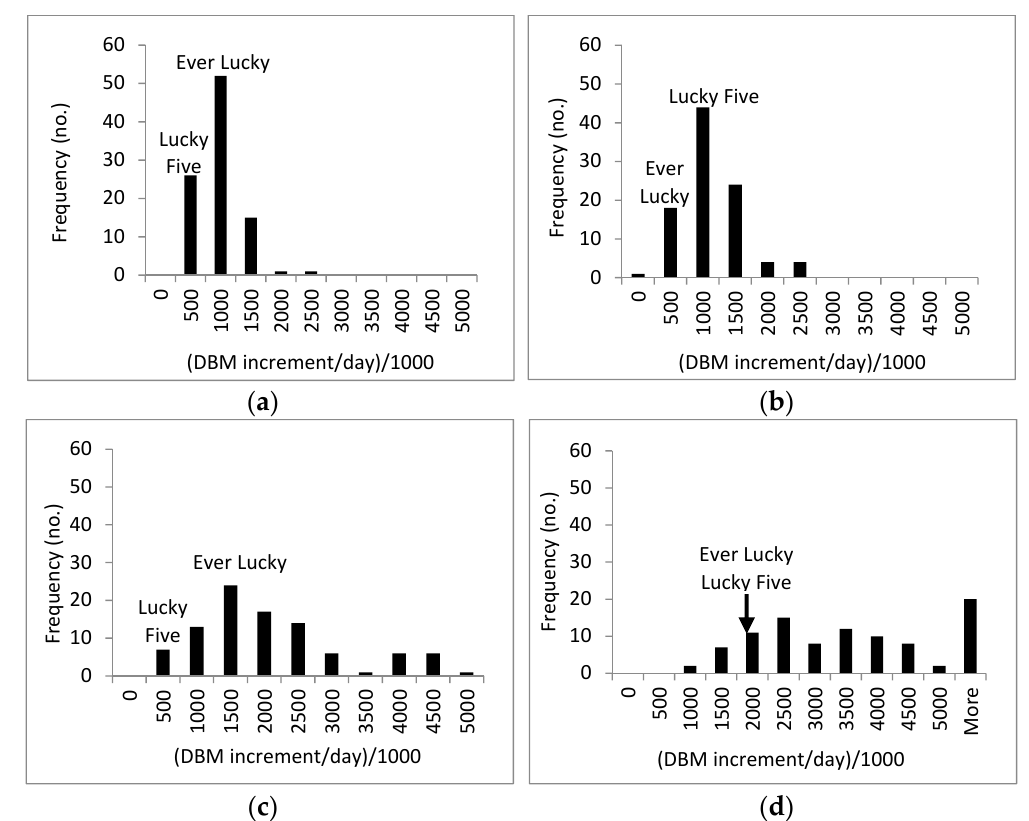
Figure 4. Frequency distribution of average daily biomass increments ( a ) before flooding, ( b ) during flooding, ( c ) during early recovery, and ( d ) during late recovery. The commercial checks are attributed to their DBM increase bin.